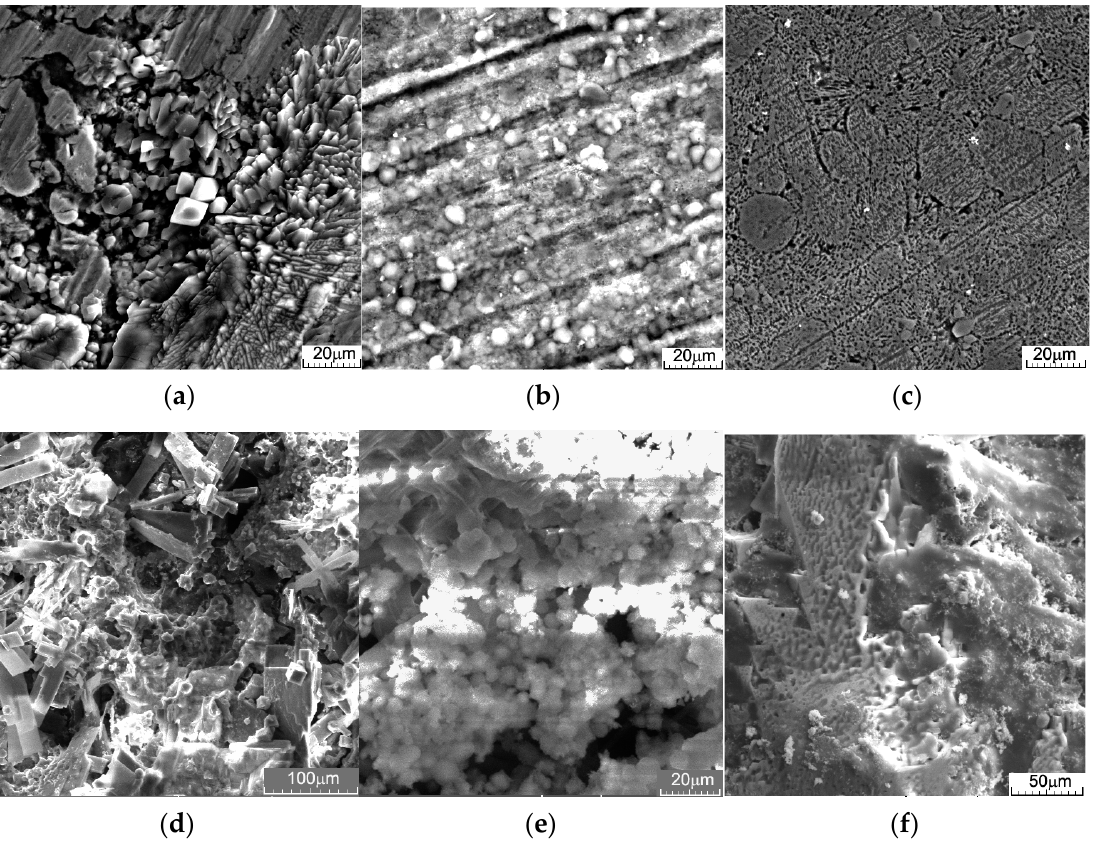
Figure 3. SEM images after immersion in Dulbecco’s, Ringer’s, and SBF of: ( a – c ) ZnMgY alloy surface; ( d – f ) the compounds resulted after immersion and air drying.